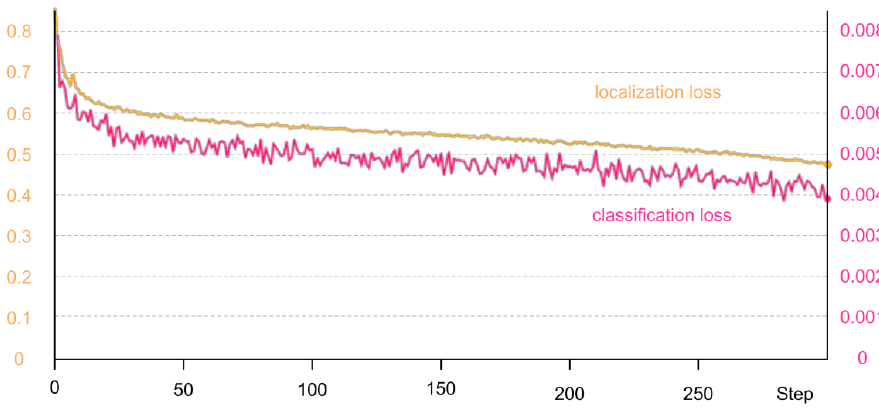
Figure 10. Classification loss ( top ) and localization loss ( bottom ) of trained YOLOv5 model.